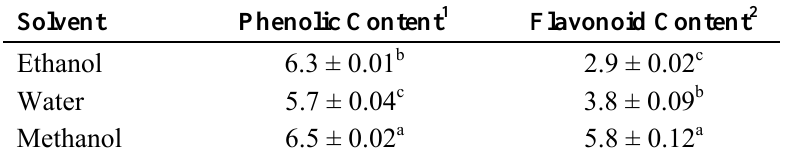
Table 1. Total phenolic and flavonoid content of saffron